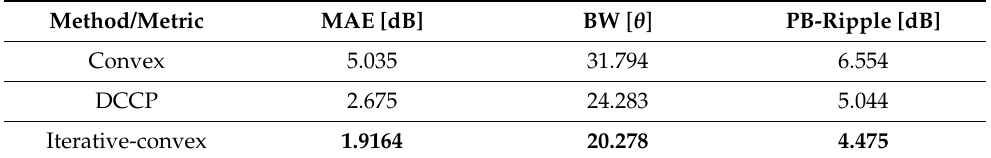
Table 1. Measurements of the beamwidth (BW), the passband-ripple (PB-ripple), and the MAE between the desired rectangular beampattern and the optimized beampatterns measured in the main lobe interval with BW = 20 ◦ . The best measurement values achieved are marked out in bold.